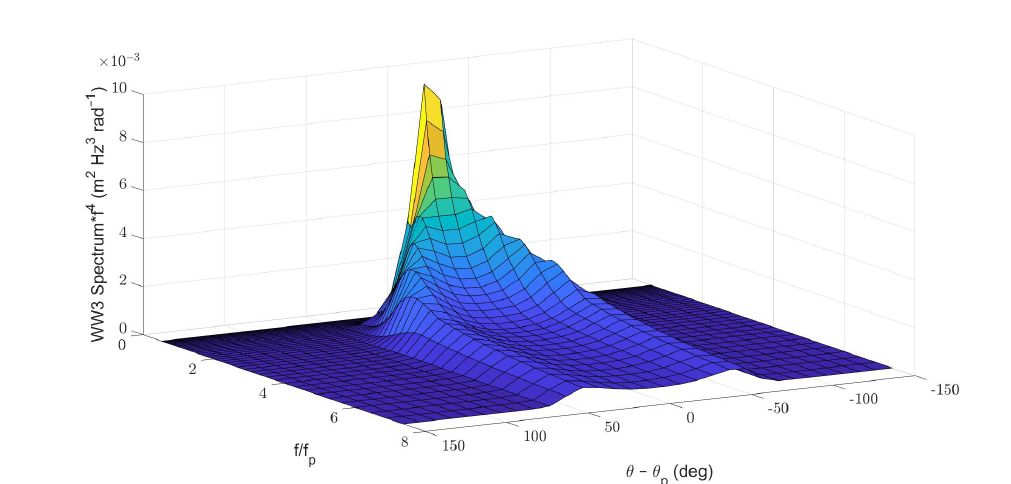
Figure 2. Same as Figure 1 for the WW3/WRT-40 hindcast for the Draupner storm on 1 January 1995 at 15:00. The two high-frequency channels are more visible than in the WW3/DIA-40 spectrum.